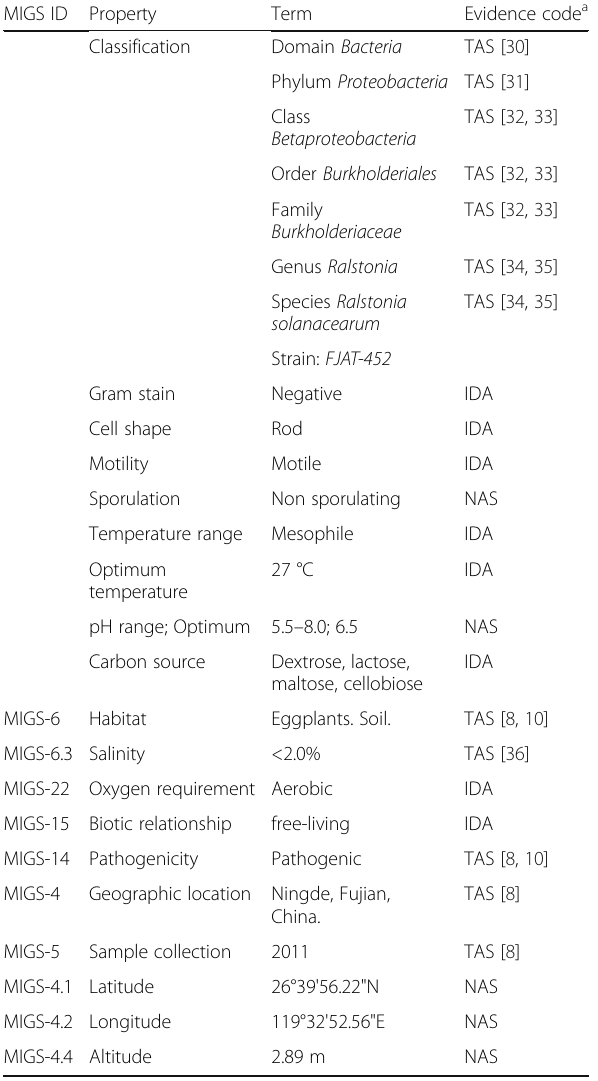
Table 2 Classification and general features of Ralstonia solanacearum FJAT-452 strain according to the MIGS recommendations [29]